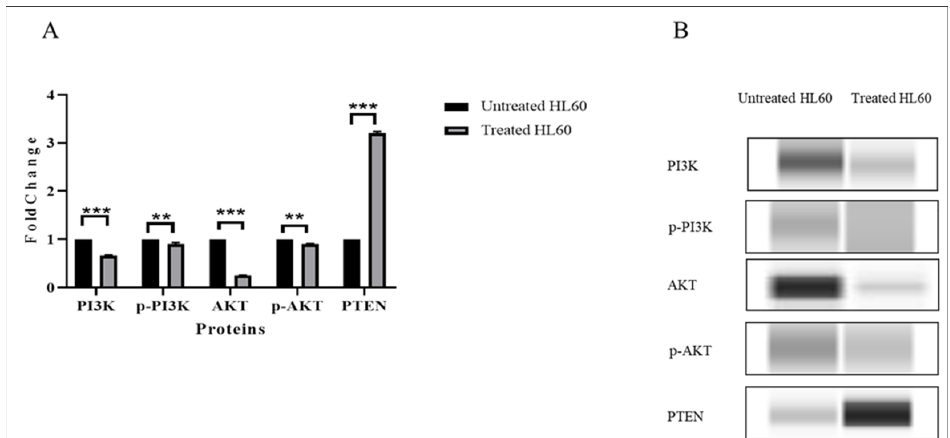
Figure 9. Effects of TQ on the expression of PI3K/AKT proteins in HL60 cells. ( A ) PI3K, p-PI3K, AKT, p-AKT, and PTEN protein expression in TQ-treated cells compared with untreated cells or negative control. Data are presented as the mean ± SEM (*** p < 0.001; ** p < 0.01). ( B ) Image of PI3K, p-PI3K, AKT, p-AKT, and PTEN protein expression from capillary Western blotting in treated and untreated HL60 cells.